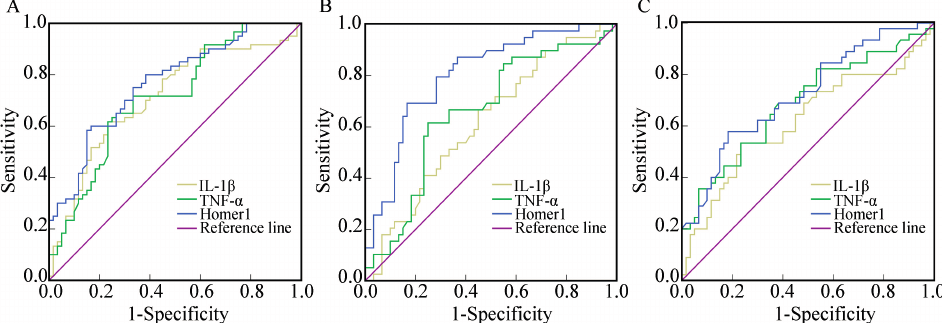
Figure 2. Receiver operating characteristic (ROC) curves. The ROC curves of the expression of Homer1, IL-1 β , and TNF- α for acute myocardial infarction (AMI) ( A ); unstable angina pectoris (UAP) ( B ); and stable angina pectoris (SAP) ( C )